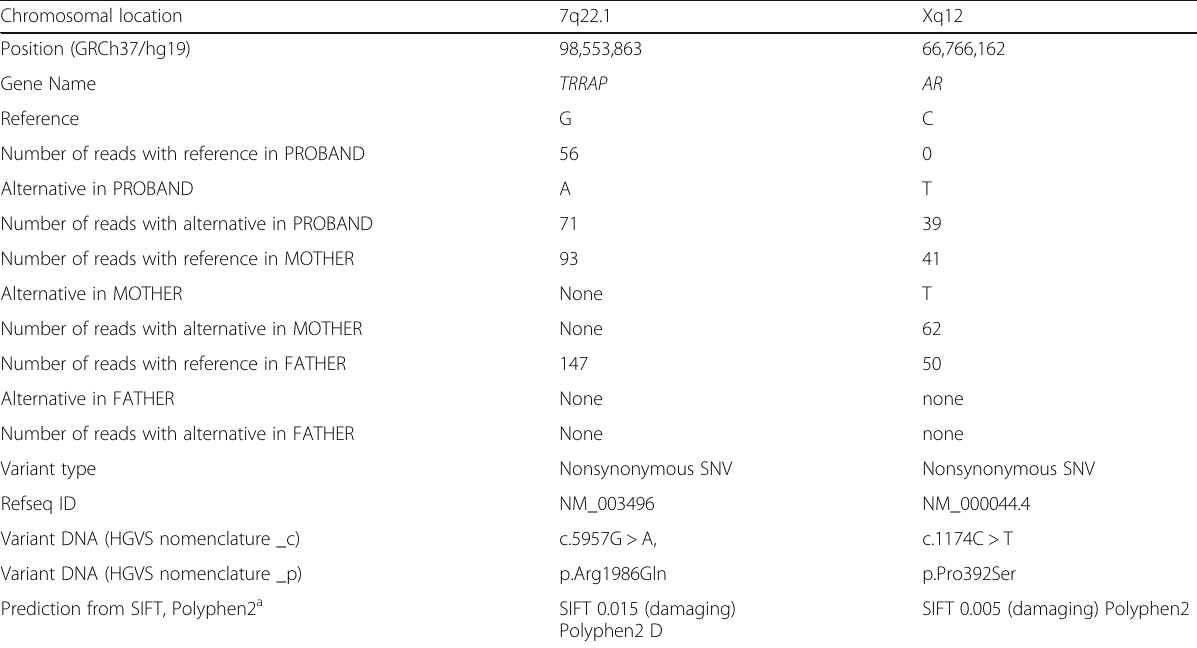
Table 2 TRRAP and AR Variant Analysis Chromosomal